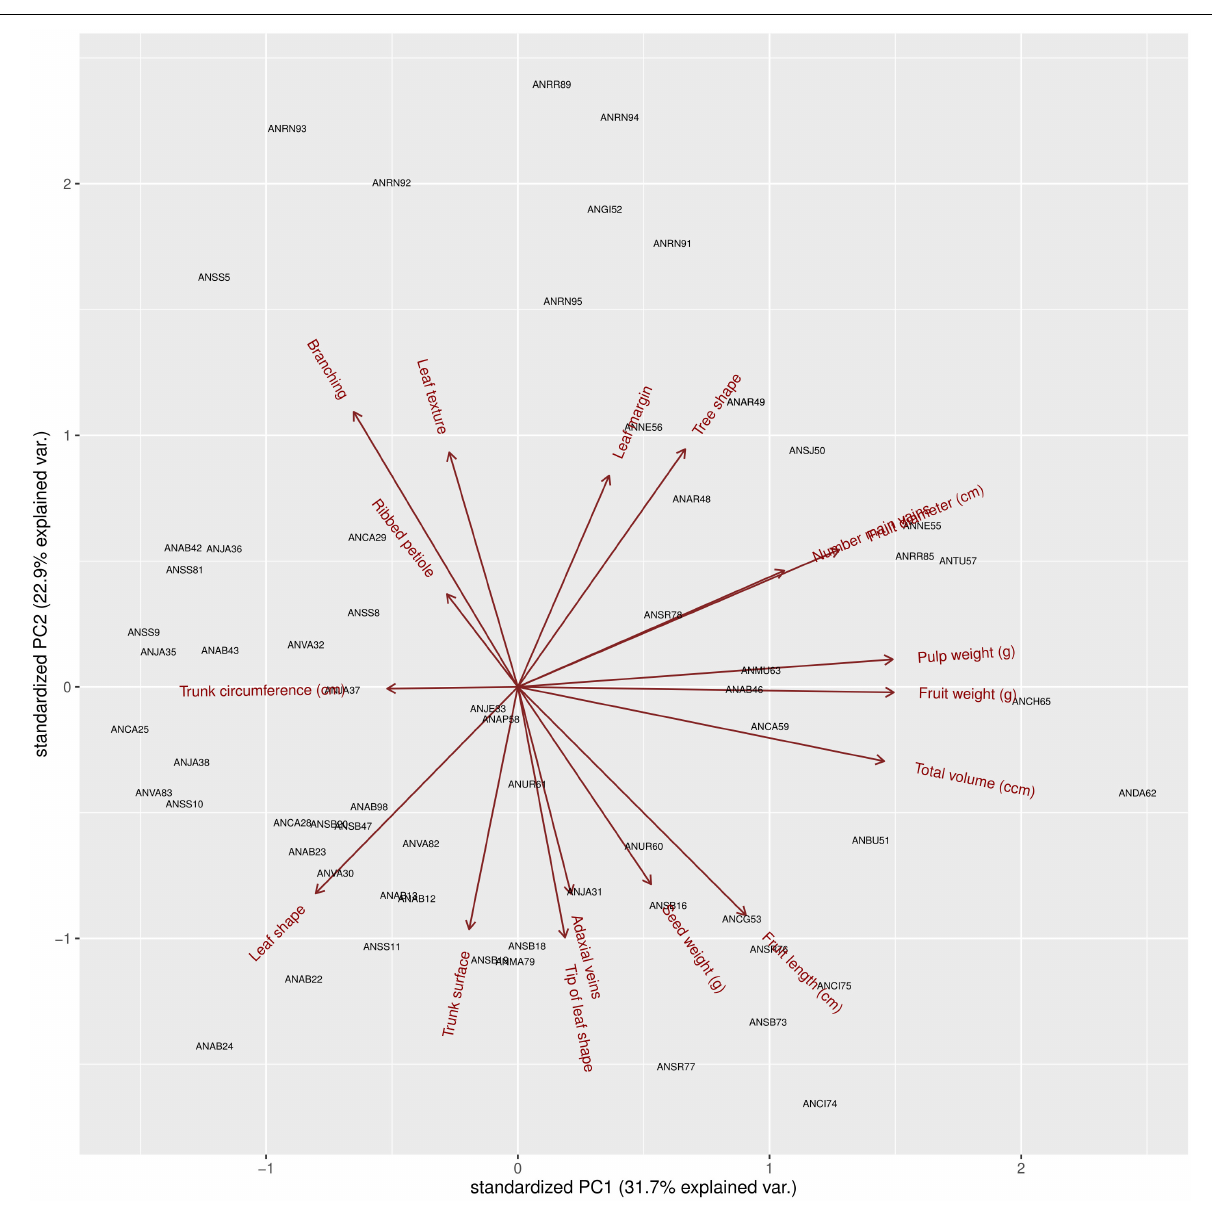
gain for this trait may be inherited to cv. Hass through seed- mediated